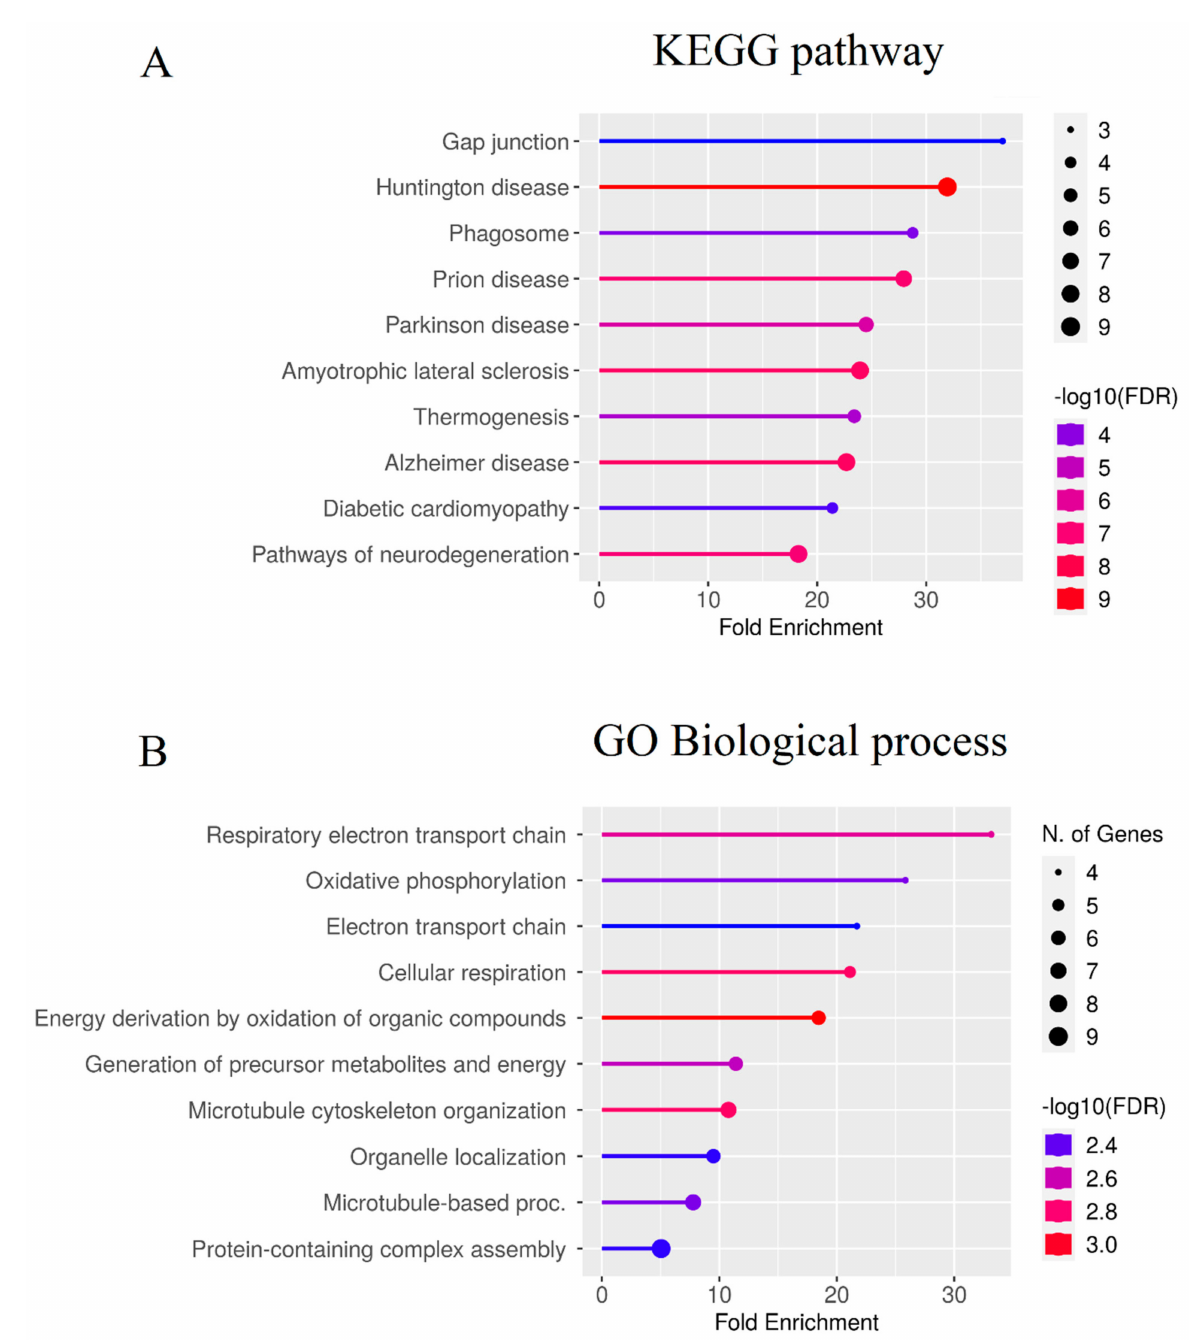
Figure 3. Enrichment analysis of the ‘hub’ genes identified in the present study. Color represents the -log10 (false discovery rate) of the pathway/terms, the X axis represents the enrichment, as assessed for top 10 genes by the KEGG (Kyoto Encyclopedia of Genes and Genomes) pathway ( A ) and GO (Gene Ontology) terms ( B ). For interpretation of the references to color in this figure legend, the reader is referred to the web version of this